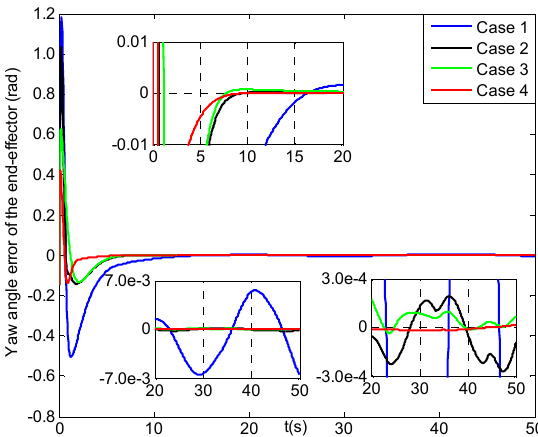
Figure 17. Yaw angle errors of the end − effector (four cases).